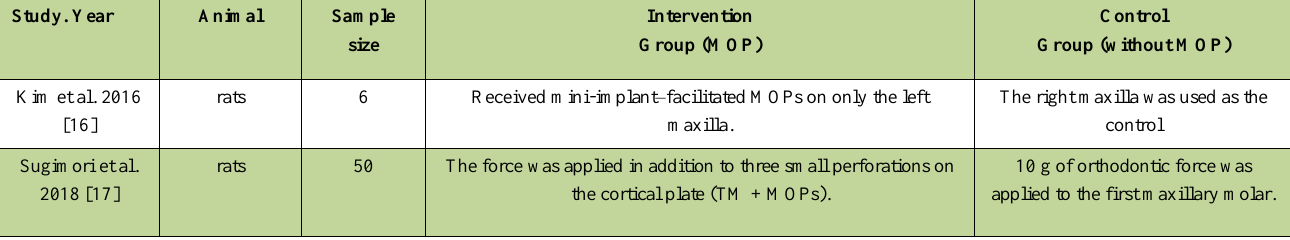
Table 3. Animal studies were selected for systematic review and meta-analysis.